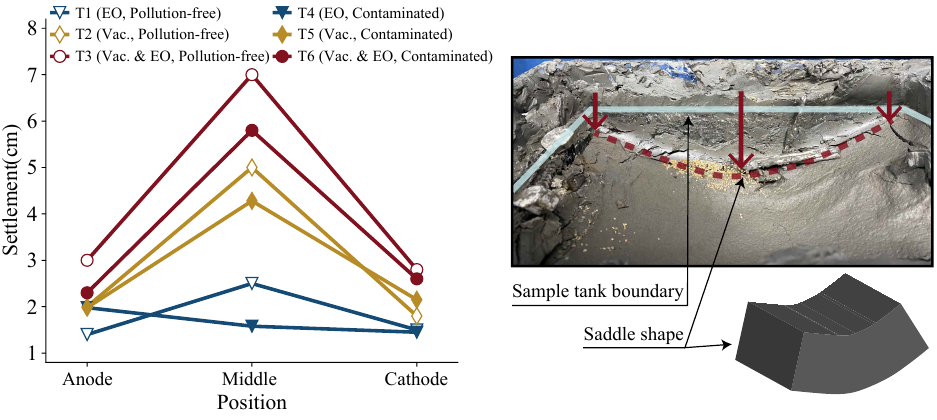
Figure 7. Distribution law of soil